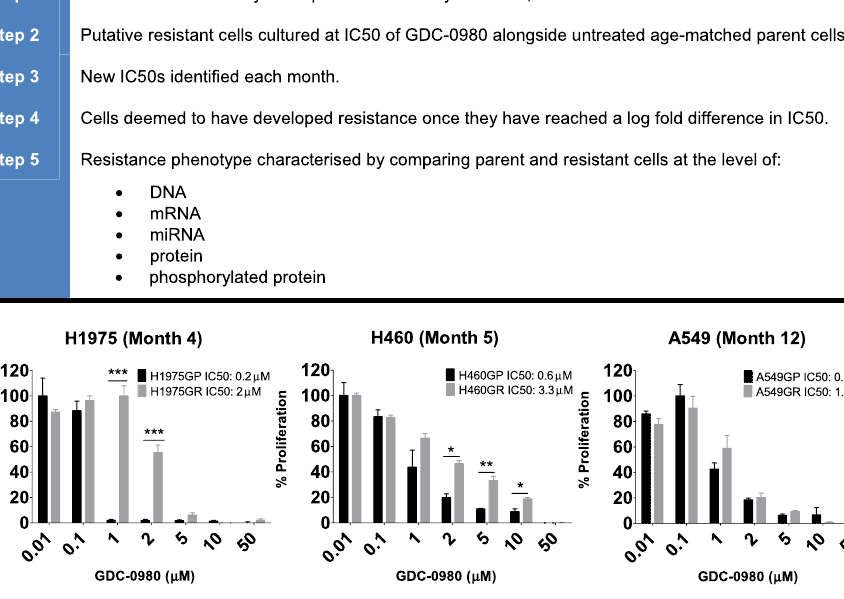
Figure 1. Development of GDC-0980 resistant NSCLC cell lines. A panel of NSCLC cell lines was exposed to GDC-0980 over an extended period in order to develop a cell line model of acquired resistance to the drug. ( a ) Work flow describing the development of GDC-0980 resistant NSCLC cell lines. ( b ) Parent and putative resistant cell lines reached a log fold difference in IC50 at month 4 for H1975 and month 5 for H460. After 12 months, A549 cells did not develop resistance to the drug. Final BrdU proliferation assay results are shown here, where proliferation was normalized on a percentage scale. Assays were performed in triplicate wells and repeated three individual times (n = 3). Data is shown as mean ± SEM. IC50s were calculated separately by linear regression and are noted here. * / ** / *** p < 0.05/0.01/0.001